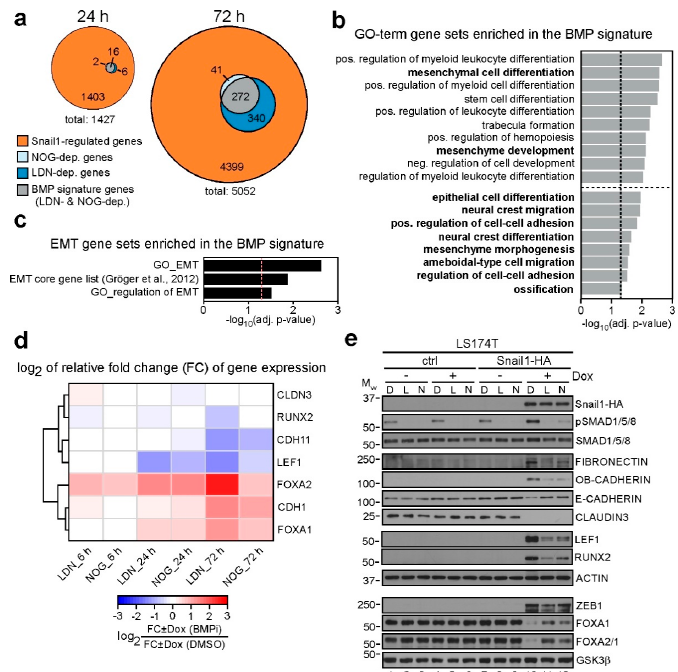
Figure 3. Defining a high-confidence BMP-dependent gene expression signature in the Snail1-induced EMT transcriptome. ( a ) Euler diagrams displaying the numbers of Snail1-regulated genes whose regulation is impaired by BMP inhibitor treatment at 24 and 72 h of Snail1-induction. When comparing the fold changes of gene regulation in the scenario of BMP inhibitor treatment to DMSO treatment, an adjusted p -value < 0.05 was used as a cutoff to determine BMP-dependent genes. Grey overlaps represent the BMP signature genes. Time points indicate duration of induction with 0.1 µg·mL − 1 Dox. ( b ) Gene set enrichment analysis (GSEA) showing significantly enriched gene sets in the BMP signature genes. Shown are the top ten significantly enriched gene sets, as well as, separated by the horizontal dotted line, additional selected significant terms. Plotted is the negative log 10 of the adjusted p -value. Vertical dotted line indicates the cutoff of adj. p -value ≤ 0.05. A complete list of terms analyzed can be found in Table S3. ( c ) GSEA results of EMT-related gene sets significantly enriched in the BMP signature genes. Vertical dotted line indicates the applied cutoff of adjusted (adj.) p -value ≤ 0.05. A complete list of terms analyzed can be found in Table S3. ( d ) Heatmap showing the impact of BMP inhibitor treatment on the regulation of genes of interest in LS174T-Snail1-HA at different time points of induction with 0.1 µg·mL − 1 Dox. Plotted is the log 2 of the relative fold change of gene expression under BMP inhibitor treatment. Relative fold change was calculated by dividing gene expression differences induced by Snail1-HA in the scenario of BMP inhibition by the differences evoked by Snail1-HA under control conditions. Inhibitors used and durations of administration are indicated on the x-axis. As their expression was not properly detected in the microarray experiment, FN1 and ZEB1 are not shown. ( e ) Western blot analyses of proteins indicated on the right. Cells were left uninduced or were treated with 0.1 µg·mL − 1 Dox and DMSO (D), 50 nM LDN193189 (L), or 100 ng mL -1 Noggin (N) for 72 h as indicated. Positions of molecular weight (M W ) standards in kDa are given on the left. Detection of ACTIN and GSK3 β was used as control for equal loading. Proteins were detected using whole-cell lysates, except for FOXA1, FOXA2, ZEB1 and GSK3 β for which nuclear extracts were used. As not all proteins could be analyzed on the same membrane, only one representative loading control is shown for the di ff erent extraction methods for reasons of simplicity. All corresponding loading controls for the images depicted can be found in Figure